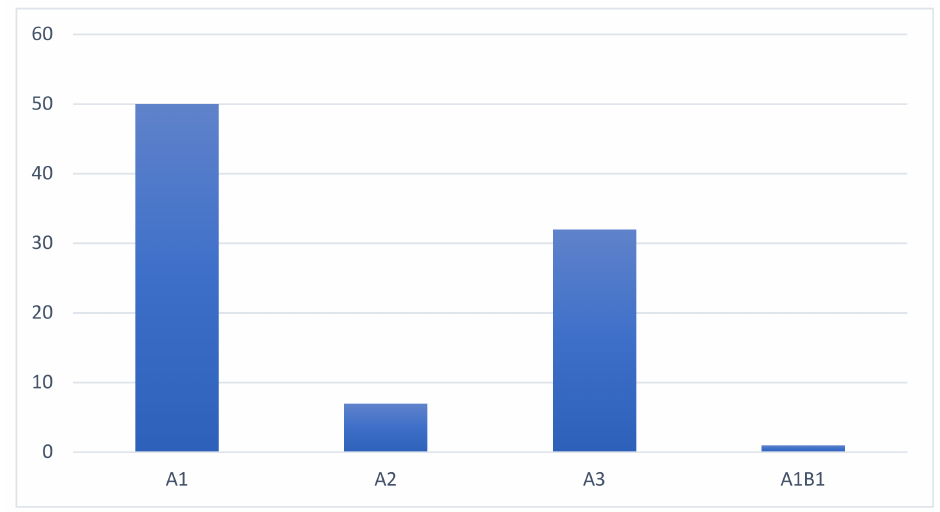
Figure 2. Fracture repartition according to the AOSpine classification system [19]. A total of 70 patients presented a one-level fracture, 7 involved a two-level lesion, and 2 involved a three-level fracture. Patients with multiple levels involved did not show any specific comorbidity such as hypothyroidism or osteoporosis. The thoracolumbar junction (T12–L1) was the most affected site: T12 was injured in 21 cases (23.3%) and L1 in 38 cases (42.2%). The next most injured vertebra was L2 in 13 patients (Figure 3). Approximately 88.9% of the fractured levels were comprised between T10 and L2.